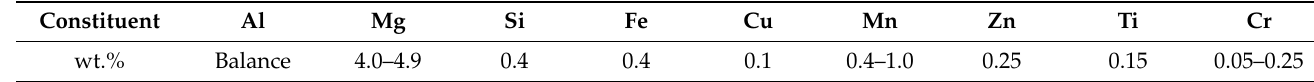
Figure 2. FE–SEM image of aluminosilicate particles: ( a ) magnification 25 k × ; ( b ) magnification 130 k × . Table 1. Composition of the material